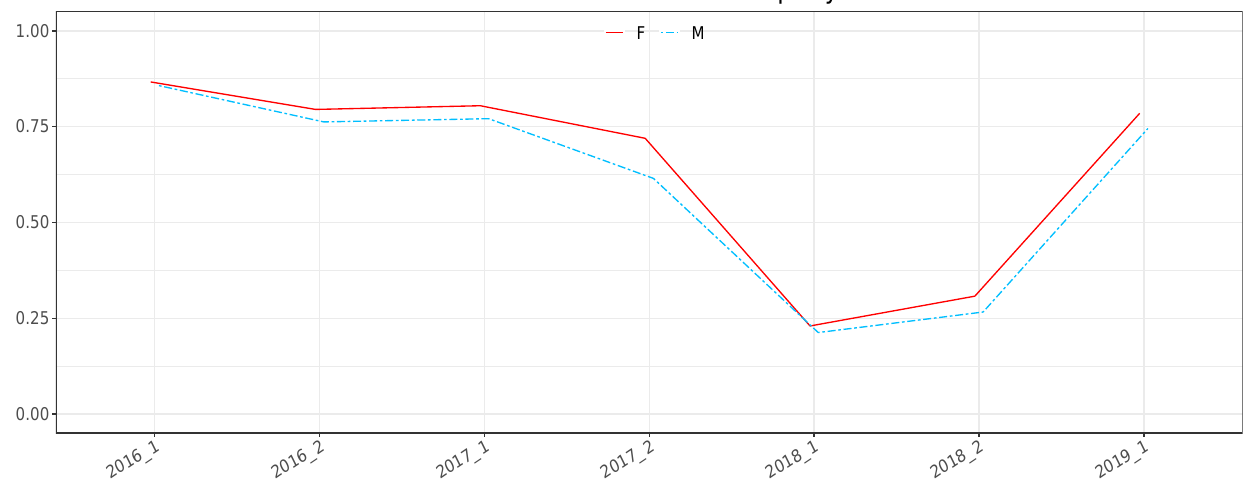
Figure 4. Value of the academic performance indicator by gender. Table 6. Students by risk group and gender. Number of Students